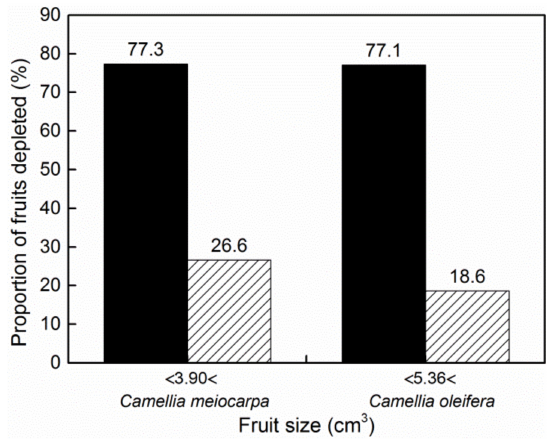
Figure 7. Proportions of fruit types depleted by the larvae smaller (black bars) or larger (lined bars) than V a value (cm 3 ) based on the logistic model in which larval size levels off.